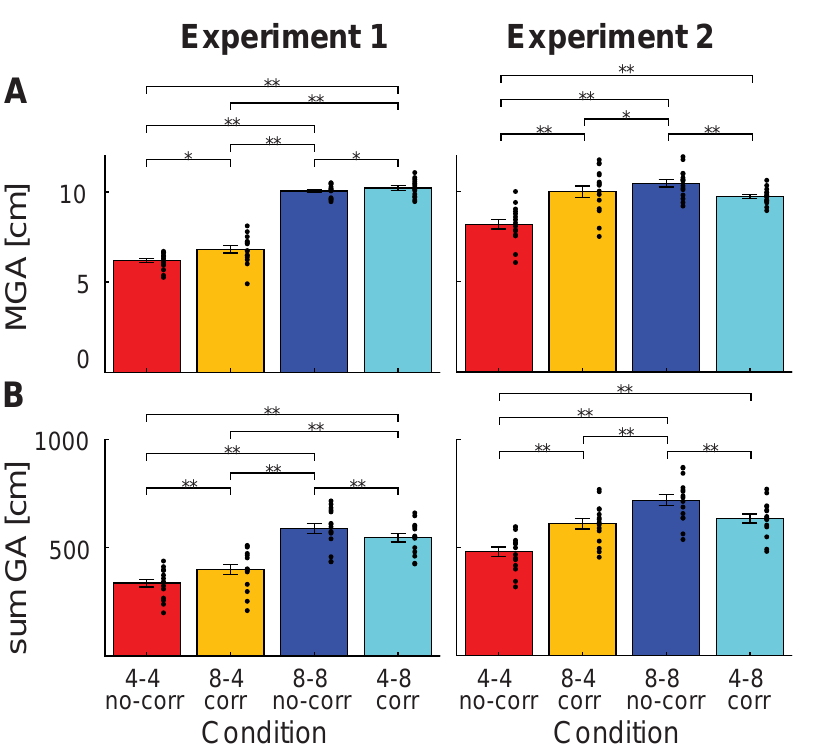
Fig 3. Grip aperture parameters for Experiment 1 (left) and Experiment 2 (right). Bars are shown for no- correction (no-corr) conditions (4–4: no-correction small and 8–8: no-correction large) and correction (corr) conditions (8–4: correction small and 4–8: correction large). (A): Maximum grip aperture (MGA), and (B): summed grip aperture (sum GA). Error bars represent standard errors, black dots indicate individual participant values. Significant differences are indicated with asterisks ( � p < 0.05, �� p <